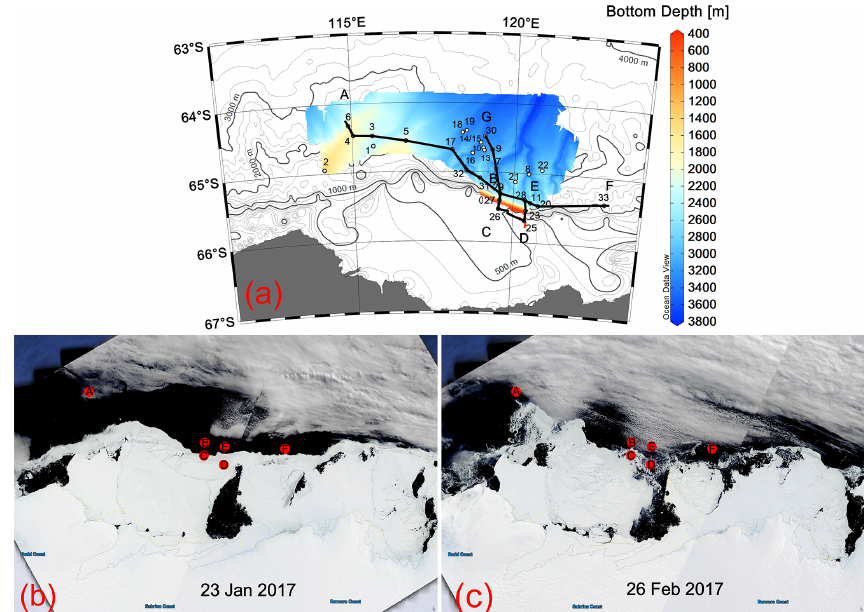
Figure 2. CTD stations map and colour-coded high-resolution bathymetry collected during the IN2017_V01 cruise (from O’Brien et al., 2020), superimposed over the International Bathymetric Chart of the Southern Ocean (contour lines). Positions A, B, C, D, E, F, and G denote along-slope and cross-slope transects (a) . The same positions A–F (red dots) along the ice edge are superimposed on satellite images (MODIS Corrected Reflectance imagery freely available from https://worldview.earthdata.nasa.gov/, last access: 15 July 2021) taken on 23 January (b) and 26 February 2017 (c) , which show the sea ice extension in the study region at the beginning and at the end of the IN2017_V01 cruise.